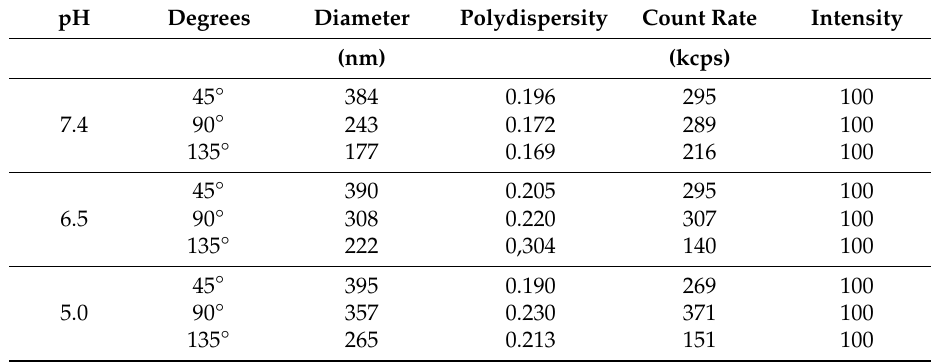
Table 1. Dynamic Light Scattering (DLS) of the synthesized PLL 78 – b –(PLL 10 – g –PHIS 15 ) at 25 °C.